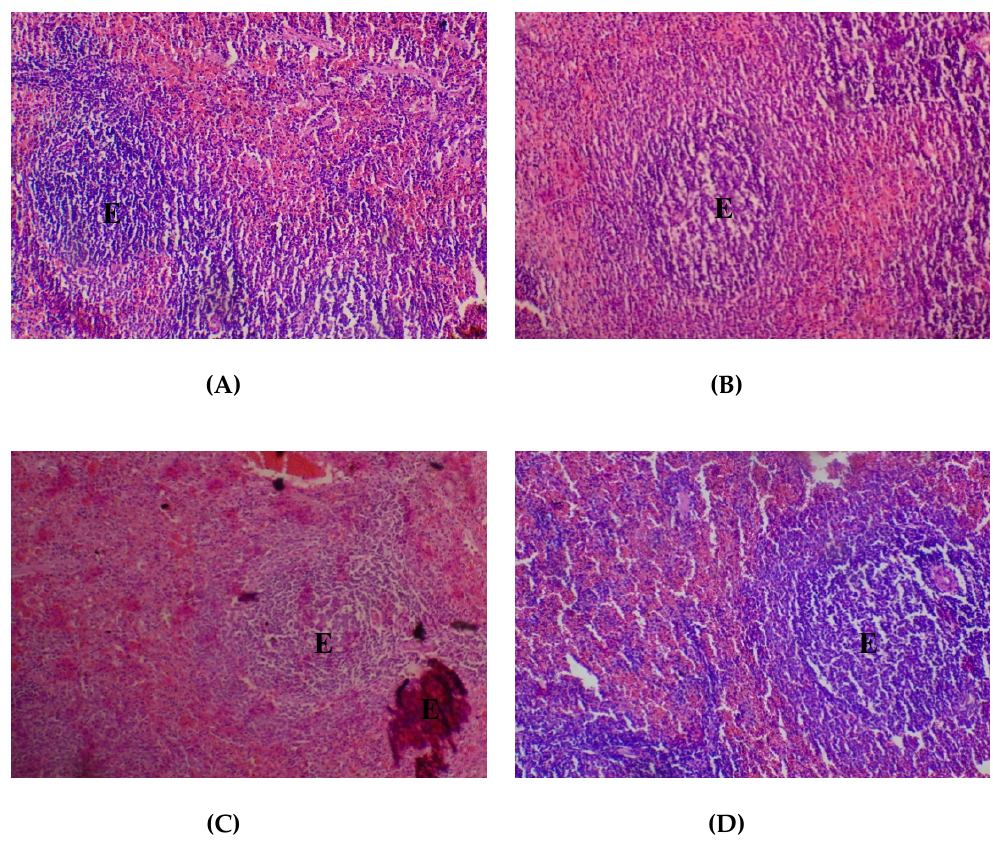
Figure 7. Histopathological presentation of rat spleen. ( A ) represents the control group treated with distilled water (Normal); ( B ) represents the group treated with 80 mg/kg T. occidentalis extract (Normal); ( C ) represents the group treated with 400 mg/kg T. occidentalis extract (Normal) and ( D ) represents the group treated with 2000 mg/kg T. occidentalis extract (Normal) ( × 400). The slides show normal lymphoid aggregates which form follicles ( E ). The surrounding sinuses show mild congestion.